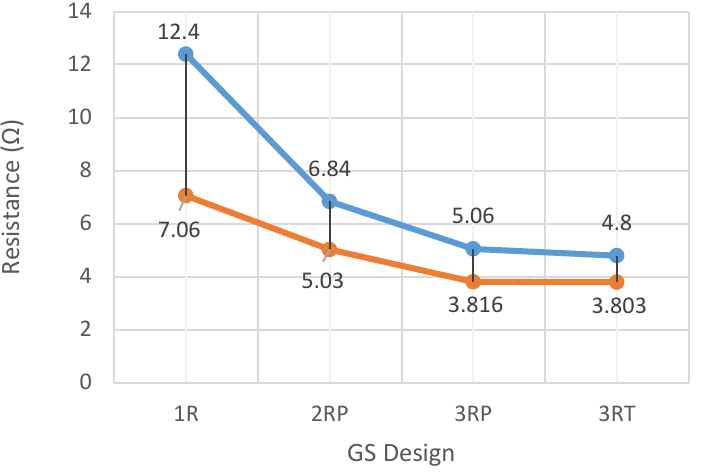
Figure 13. GR vs. GS design in